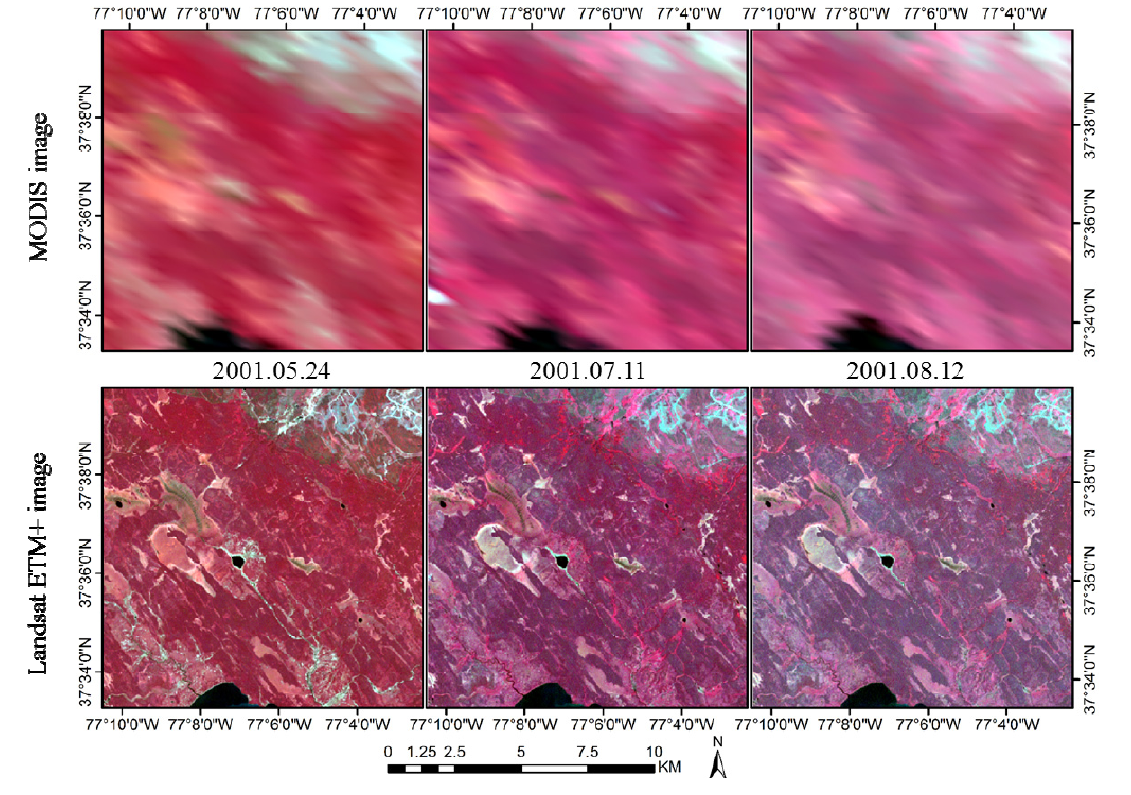
Figure 4. The MODIS ( upper ) and Landsat ETM+ ( lower ) images in a forest region (NIR-red-green composite and identical linear